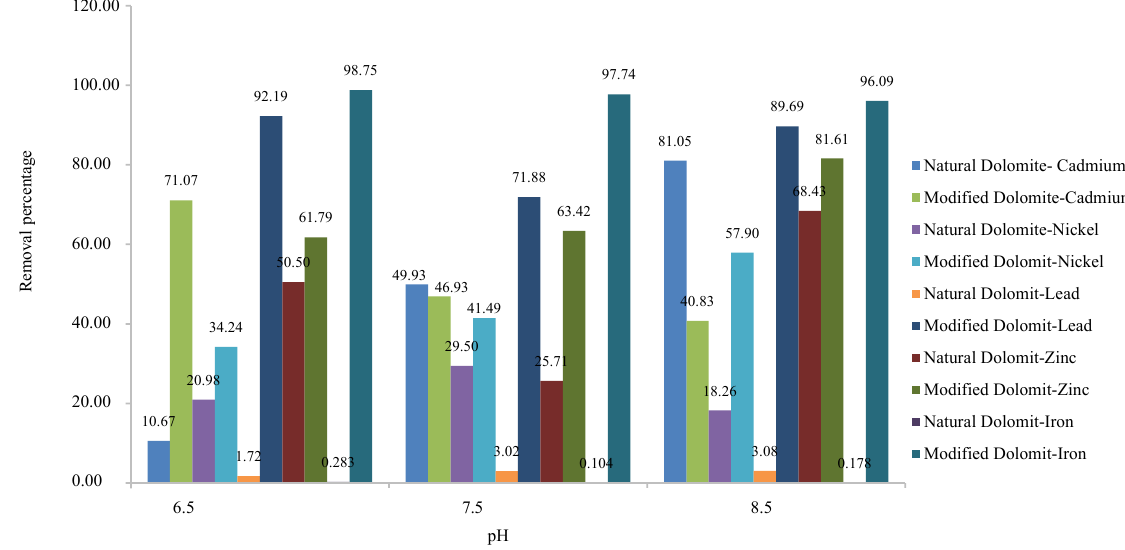
Fig. 16. Comparison of removal rate of heavy metals with optimum contact time and adsorbent dosage in 5 mg/l of solution and specific ph using natural and modified